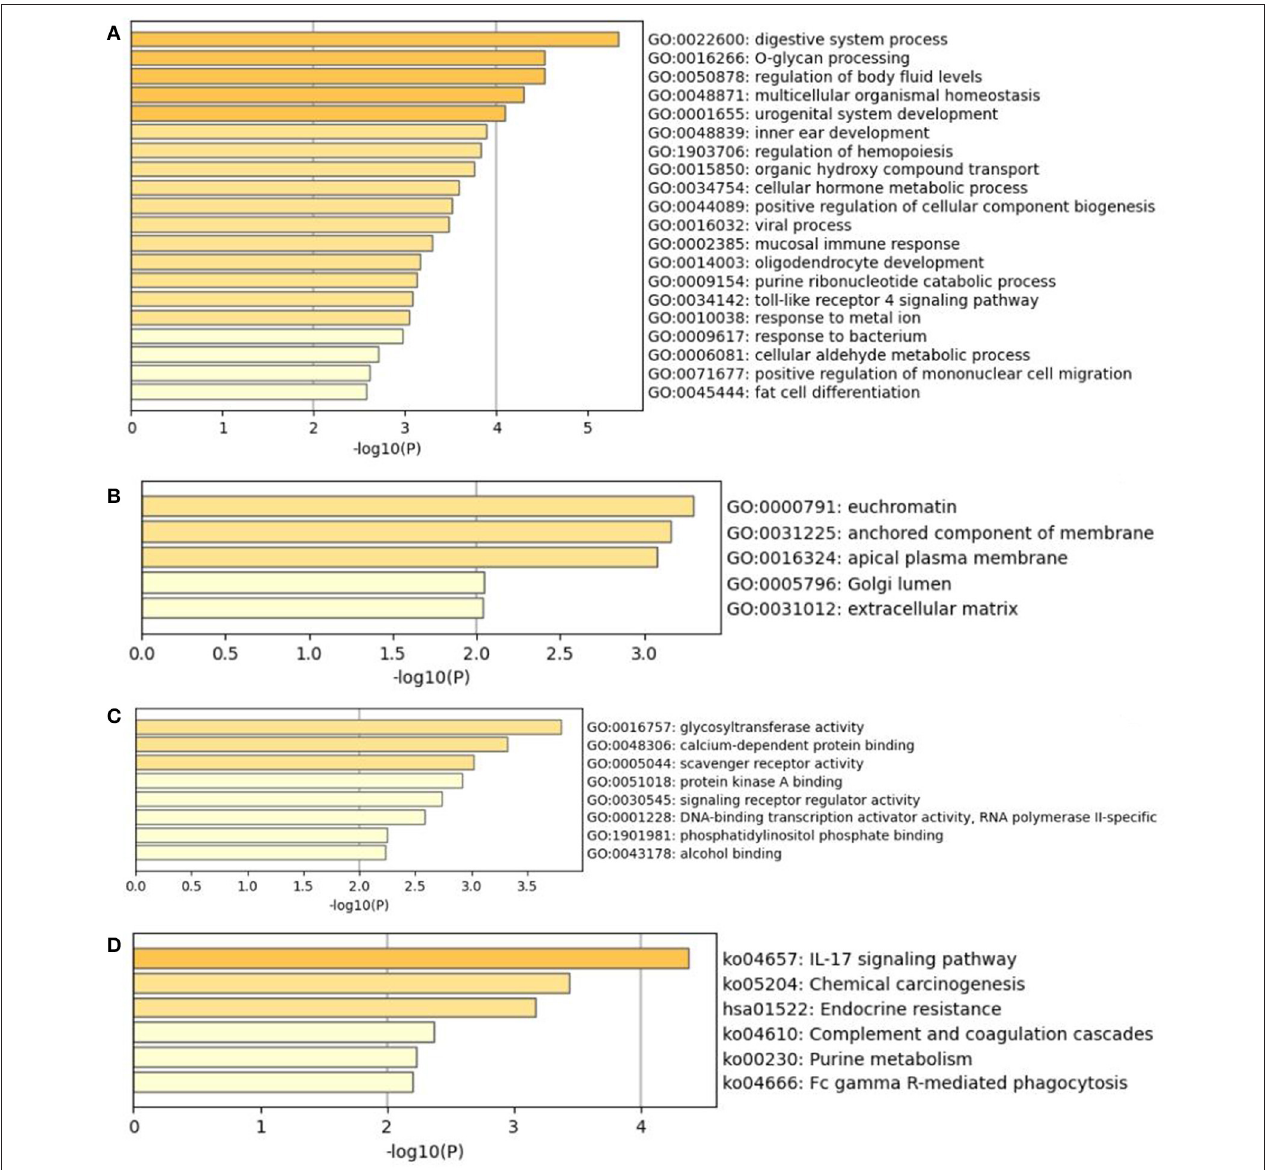
FIGURE 5 | The GO analysis and KEGG pathway enrichment of hub mutant gene’s targeted genes. (A) Biological processes (GO-BP). (B) Cellular components (GO-CC). (C) Molecular functions (GO-MF). (D) KEGG pathway of hub mutant gene’s targeted